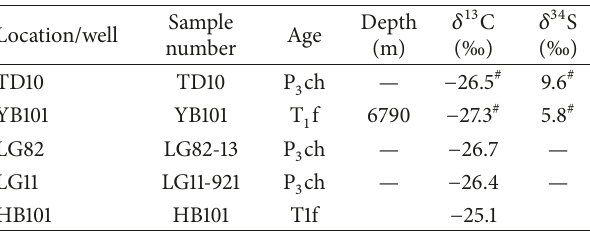
Table 5: Solid bitumen 𝛿 13 C and 𝛿 34 S